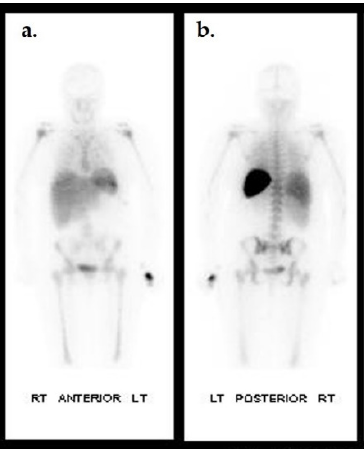
Figure 7. Biodistribution of 111 In-oxine WBC in a non-infected individual. Anterior ( a ) and posterior ( b ) planar images of a healthy patient 24 h after 111 In-oxine-labeled WBC injection. Uptake is seen in the spleen, liver, and bone marrow.